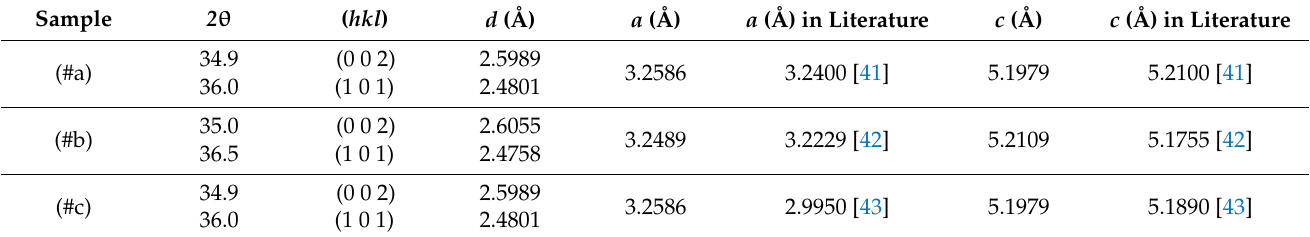
Table 2. Values of the a and c crystalline parameters determined from the XRD spectra treatment. Sample